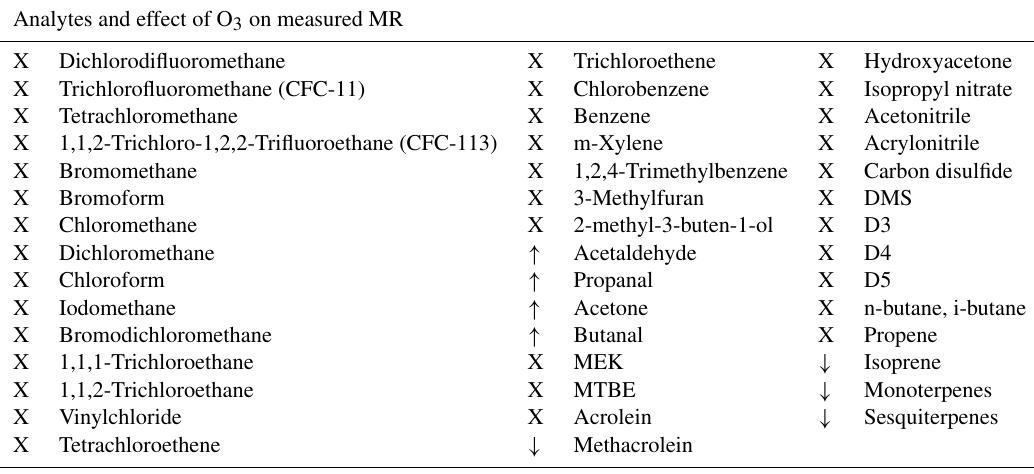
Table 2. Measured species and effect of ozone. X: no effect, ↓ : negative interference and ↑ : positive interference. Analytes and effect of O 3 on measured MR